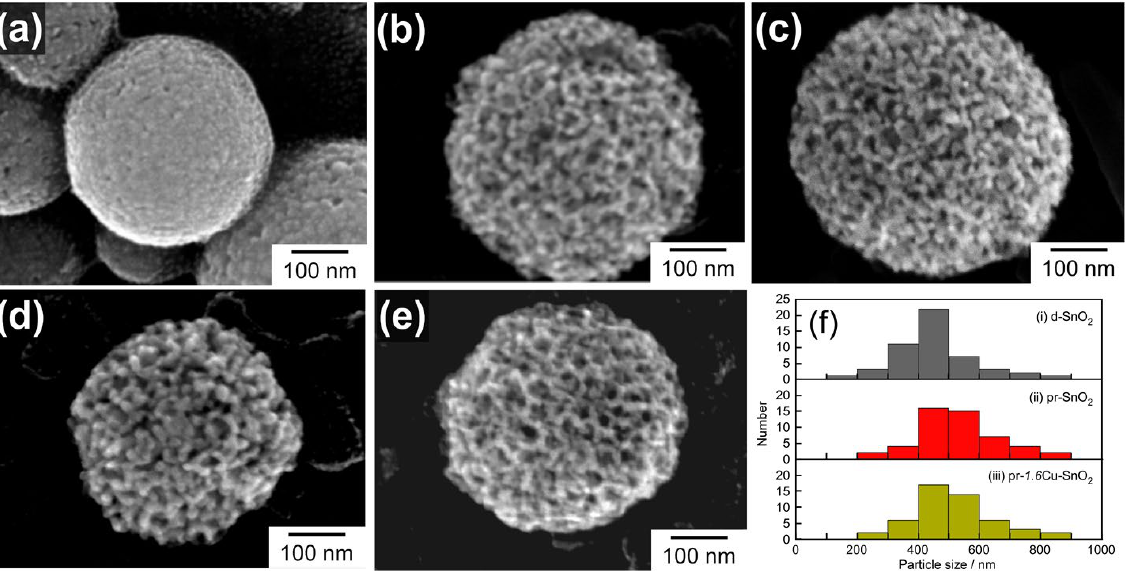
Figure 2. SEM photographs of as-prepared ( a ) d-SnO 2 , ( b ) pr-SnO 2 , and representative pr- w Cu-SnO 2 ( w : ( c ) 0.4 , ( d ) 0.8 , ( e ) 1.6 ) powders, together with ( f ) their particle-size distributions obtained